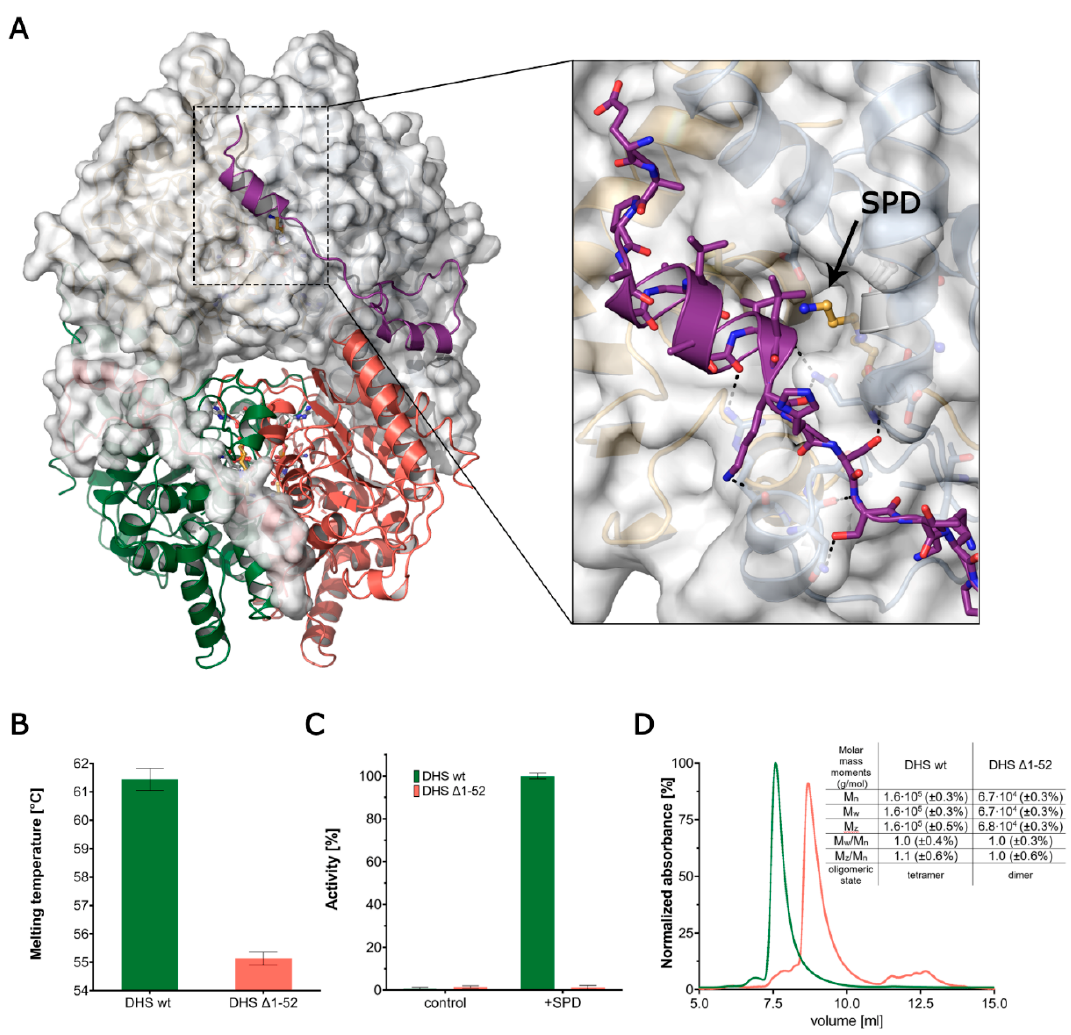
Figure 3. The role of the ball-and-chain motif. ( A ) The structure of DHS-NAD-SPD is shown with one dimer as a cartoon and one in surface representation. The ball-and-chain motif observed in subunit A is shown in purple. This region folds on the symmetry-related subunit over the entry to the active site. The enlargement shows the hydrogen bond network (black dashed lines) of the N-terminal fragment with the globular part of the enzyme. The opening of a tunnel, leading to the active site and a spermidine residue within, is indicated by an arrow. ( B ) The decrease of stability of the truncation mutant expressed as a drop in the measured Tm. ( C ) The relative activity of wild-type DHS and its truncation mutant. ( D ) The SEC-MALS elution profiles of wild-type and truncated DHS. The table summarises the numerical results of the MALS measurement. In all plots, green refers to the full-length DHS and red to the truncated